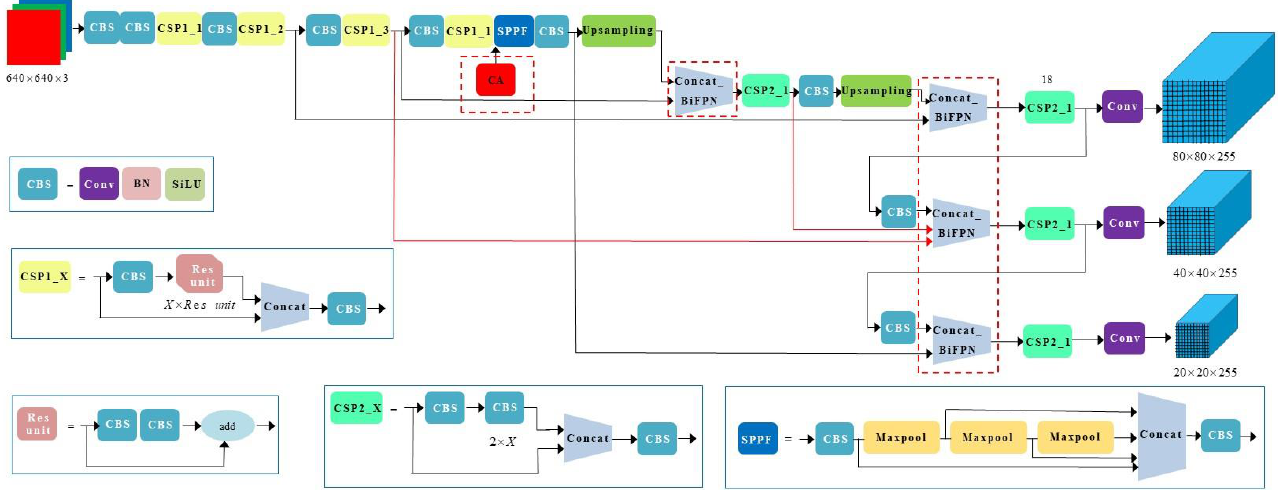
Figure 2. The structure of improved YOLOv5.